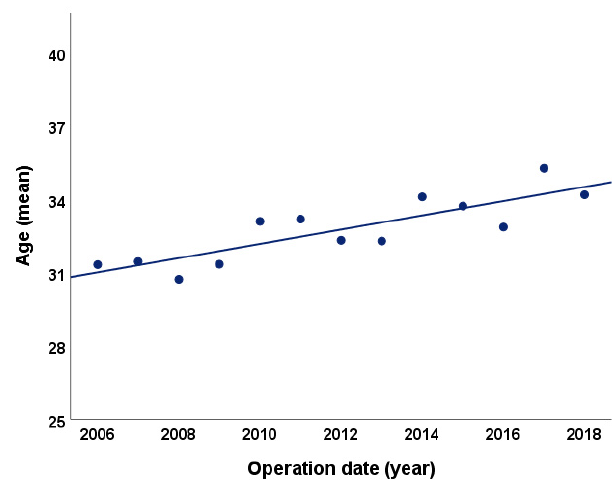
Figure 1. Mean age of patients by year.